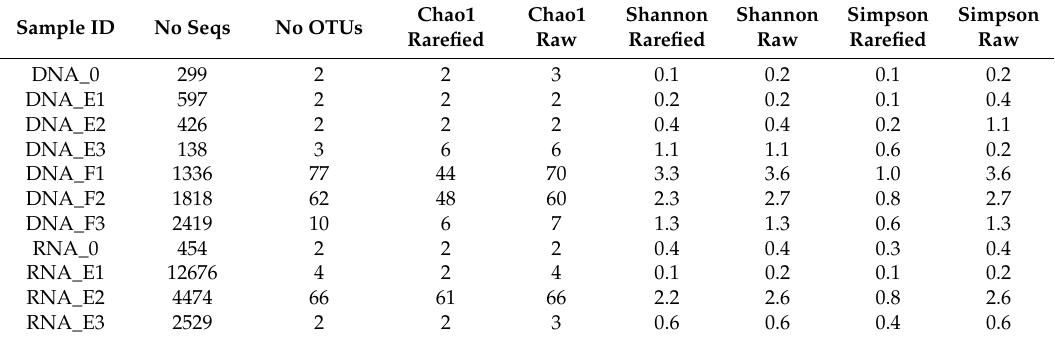
Table 4. Alphadiversity analysis of the archaeal community detected from the DNA and RNA of the original fracture fluid (DNA_0 and RNA_0, respectively), enriched microcosms (DNA_E1-3 and RNA E1-3) and the acetate assimilating community detected from the labelled fractions (DNA-F1-3). This table presents both the number of sequences (No of Seqs) and OTUs (No of OTUs) along with Chao1 richness estimate and Shannon and Simpson diversity indices, respectively, and shows both raw data and normalized (rarefied) data based calculations.